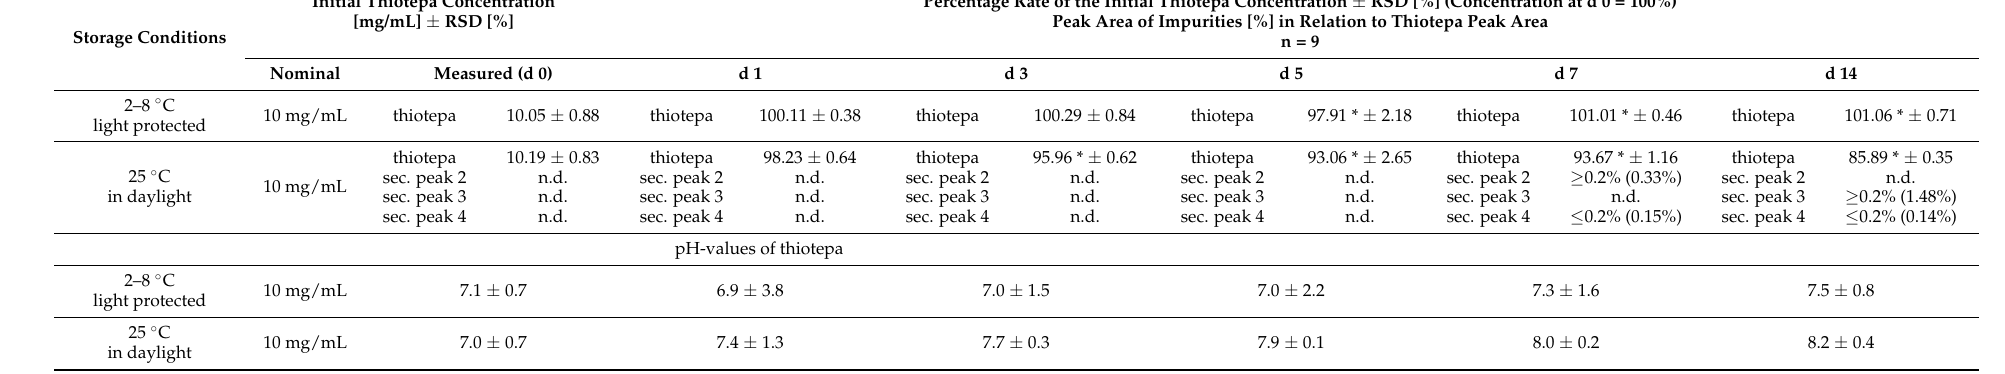
Table 2. Thiotepa concentration, peak areas of secondary peaks and pH of thiotepa concentrate 10 mg/mL in the punctured vial stored under two different conditions for 14